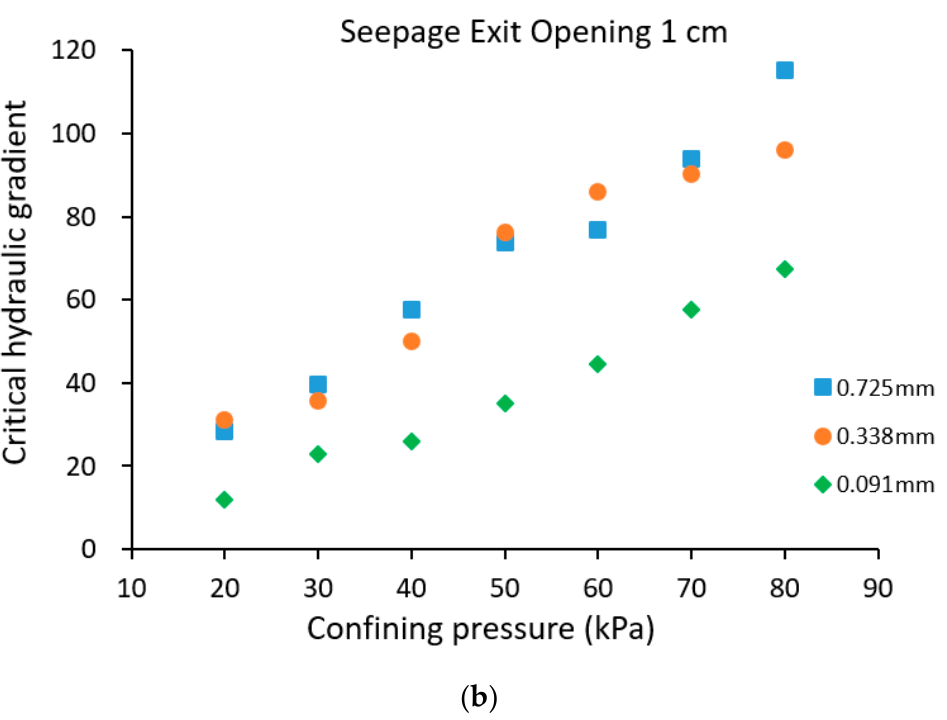
Figure 12. Estimated critical hydraulic gradient: ( a ) seepage exit opening of 0.4 cm; ( b ) seepage exit opening of 1 cm.